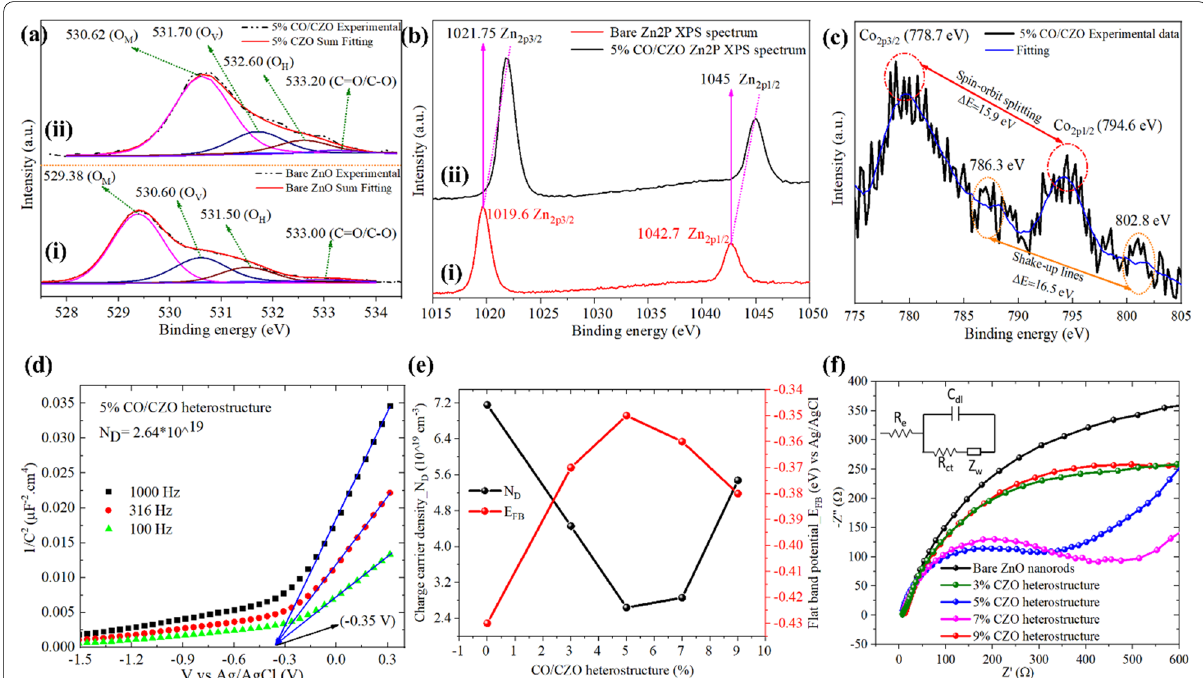
Fig. 4 High-resolution core-level XPS a -i O1s and b -i Zn2p spectra of bare ZnO. a -ii, b -ii, c O1s, Zn2p, and Co2p spectra for the 5% CO/CZO heterostructure, respectively. d Mott–Schottky plot for the 5% CO/CZO. e Variation in E FB and N D of the bare ZnO and the 3%, 5%, 7%, and 9% CO/ CZO heterostructures. f EIS plot of the bare ZnO and 3%, 5%, 7%, and 9% CO/CZO heterostructures, where C dl , R e , R ct , and Z w correspond to the double-layer capacitance, electrolyte, charge transfer, and Warburg resistance, respectively, of the equivalent circuit shown in the